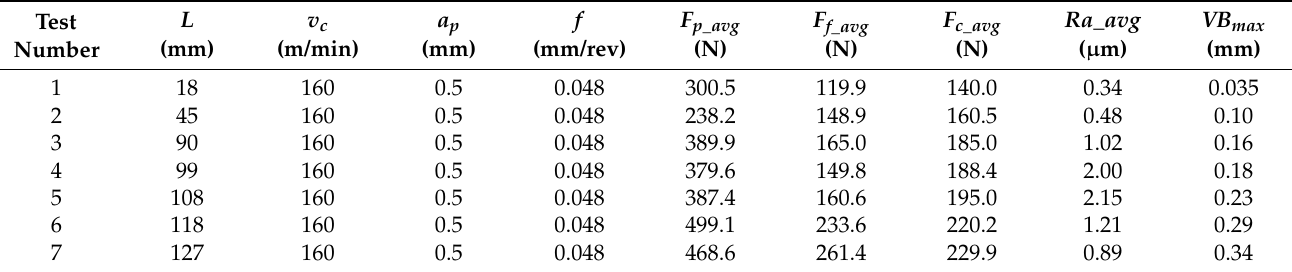
Table 5. Summary of the results of the measurements of the cutting edge wear, the values of the total cutting force components, and Ra arithmetic mean value of surface roughness for the case of turning with a speed v c = 160 m/min.